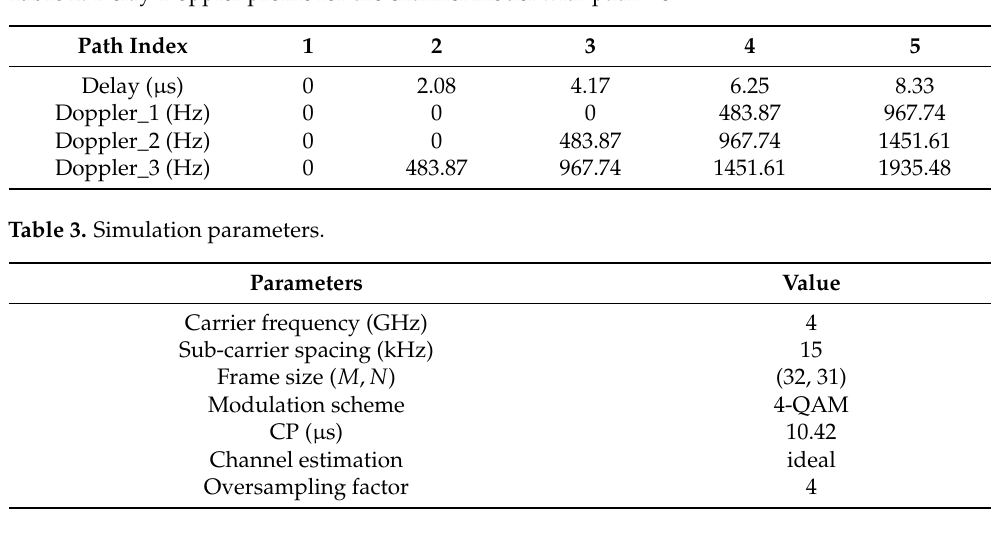
Table 2. Delay-Doppler profile for the channel model with path = 5.